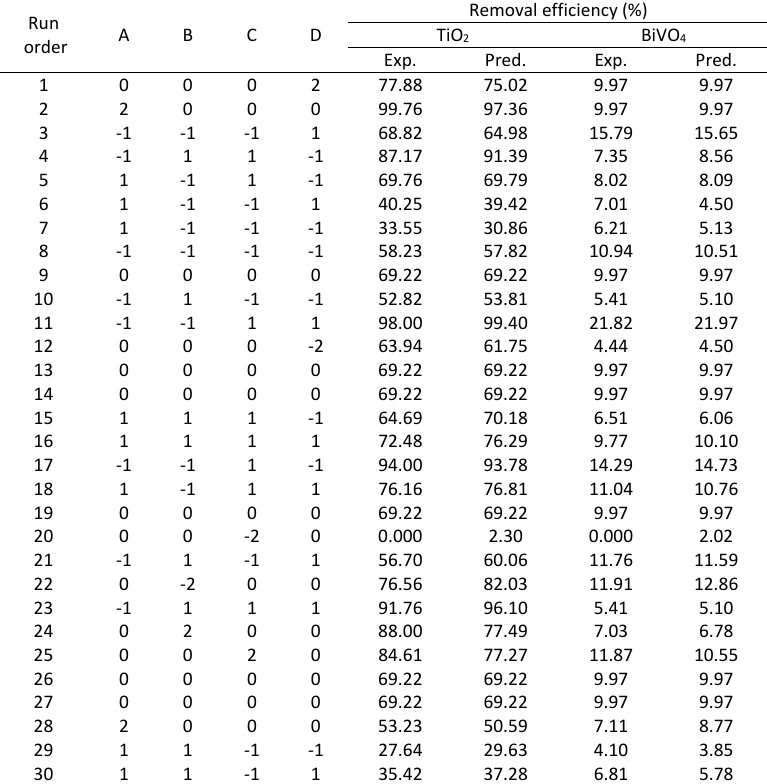
Table 4: Estimated regression coefficients for UV/TiO 2 process of AO10 removal